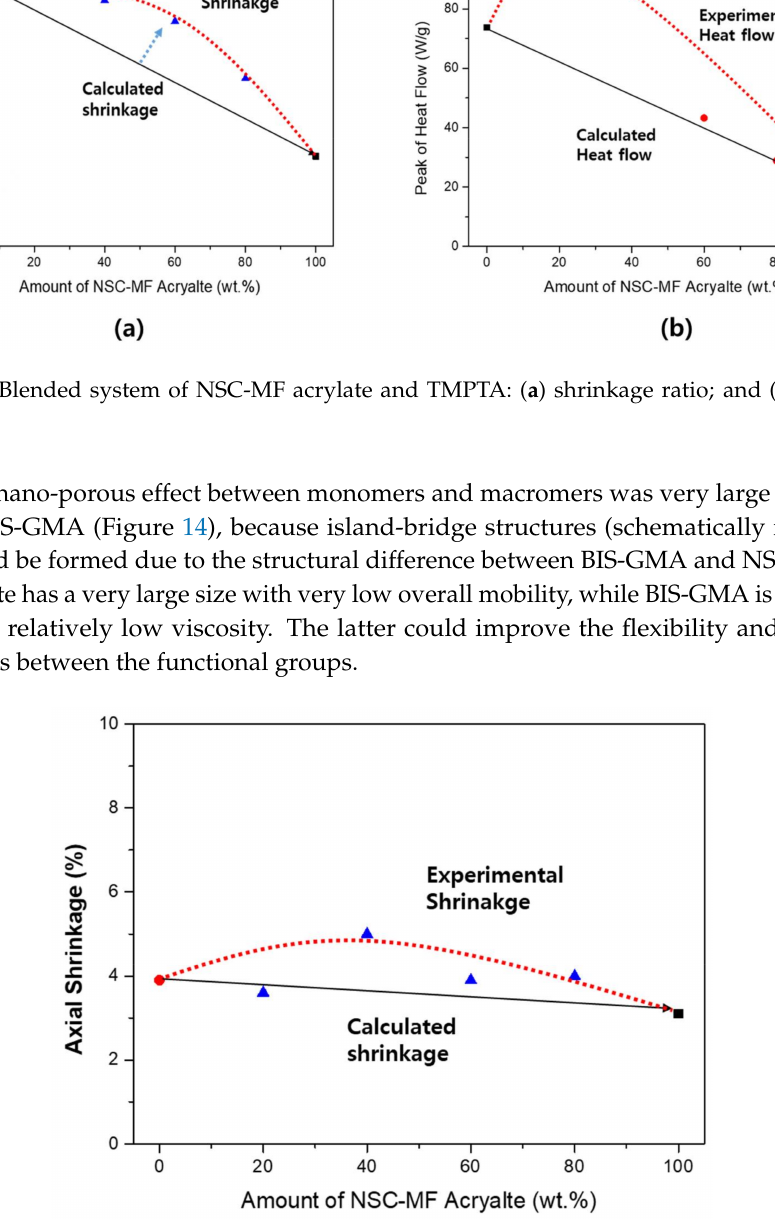
Figure 14. Shrinkage of the blended system of NSC-MF acrylate and